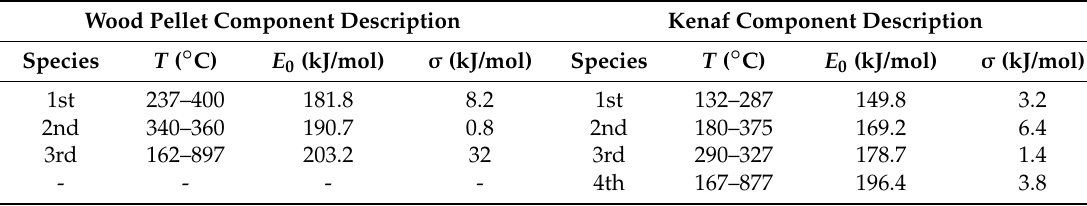
Figure 6. Activation energy distributions of the pseudocomponents; ( a ) wood pellets and ( b ) kenaf. Table 5. Component description for the DAEM of the biomass samples.